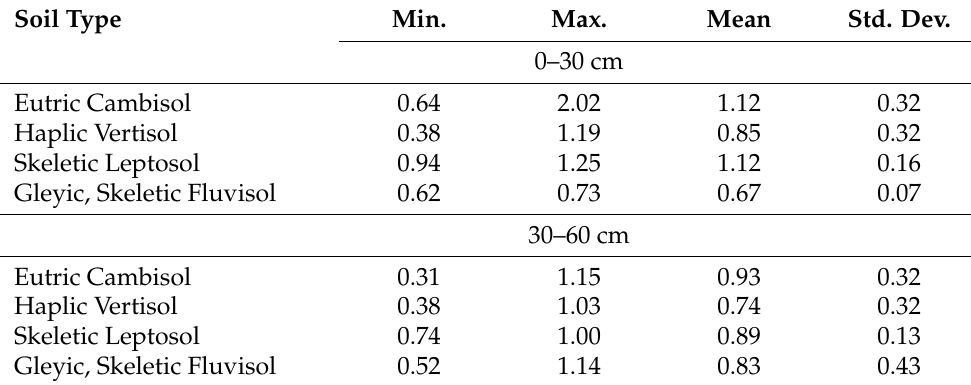
Table 4. SOC concentrations (%) in soil layers at 0–30 and 30–60 cm (N = 112). Soil